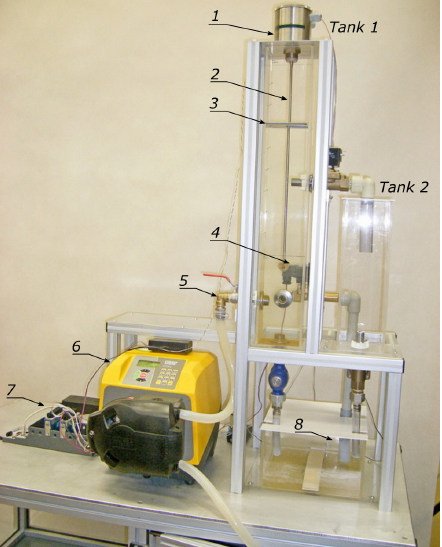
Figure 6. General view of the experimental setup. Main components: 1—NSK sensor, 2—sensor